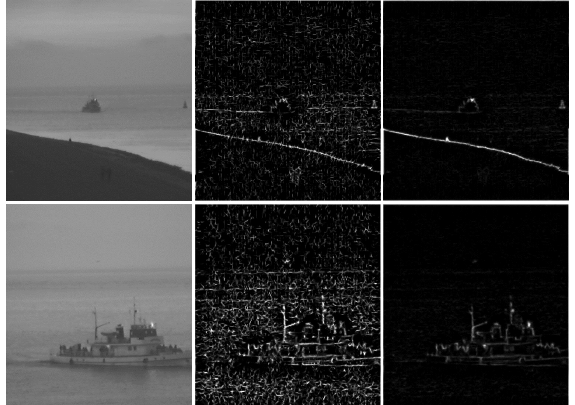
Figure 2. The results of PC and LWA. From left to right: the raw image; the PC map; and the LWA map. Note that the LWA map is much more robust and stable than the PC map, especially in texture-less image regions such as the sky, sea, and